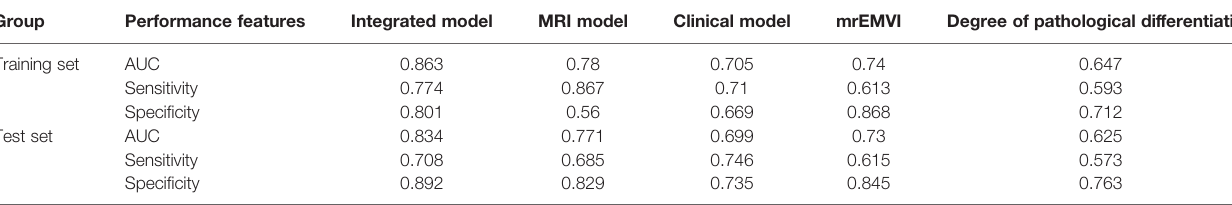
TABLE 4 | Diagnostic ef fi cacy of different models and independent clinical